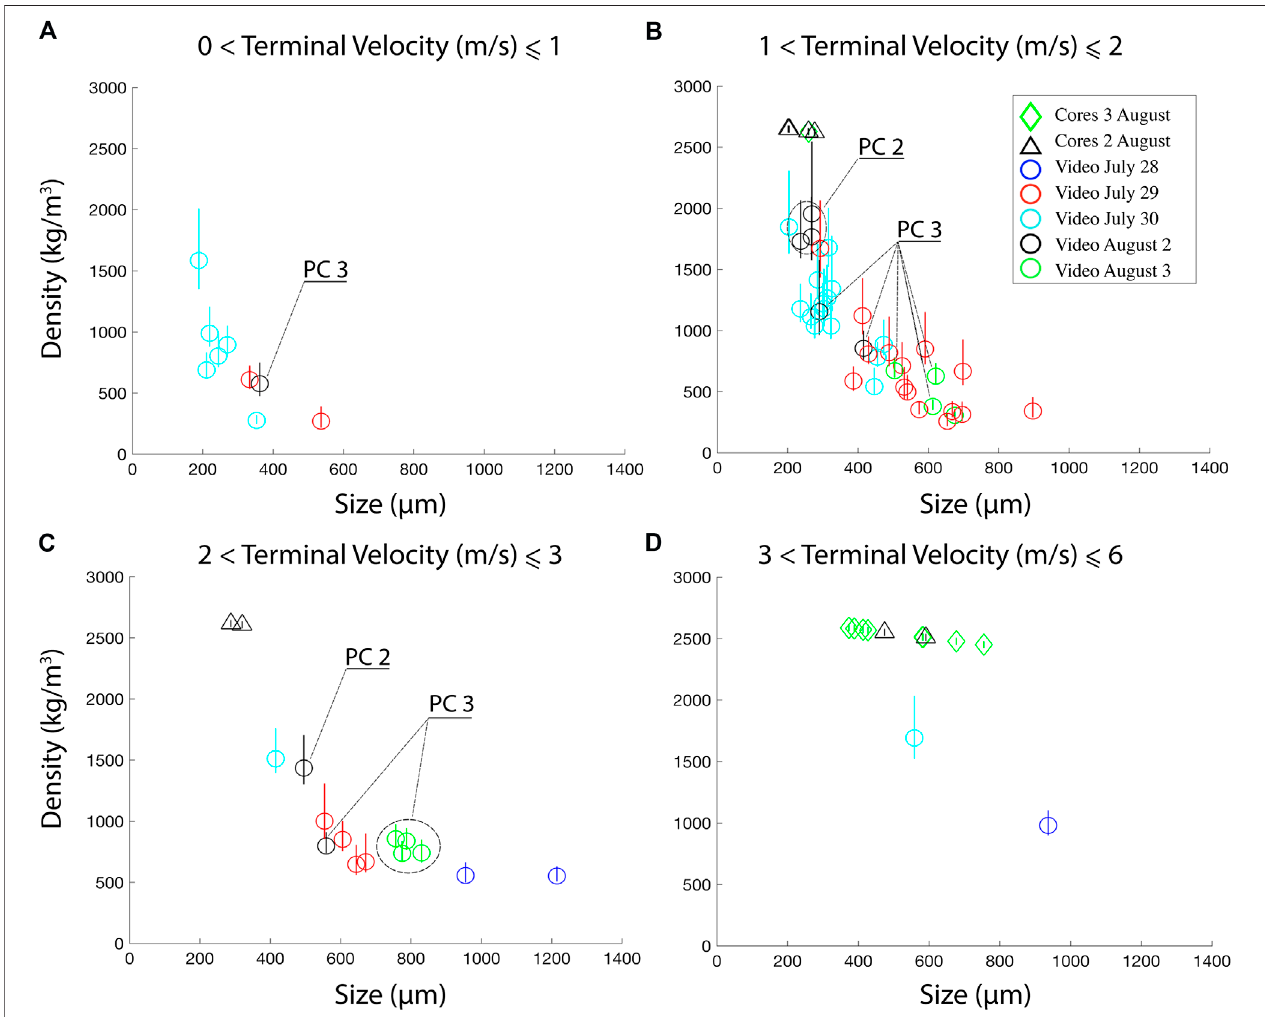
FIGURE 6 | Iso-velocity sections in the space Density – Terminal Velocity – Size for the studied aggregates. (A) Aggregates falling with velocity lower than 1 m/s, (B) between 1 and 2 m/s, (C) between 2 and 3 m/s, and (D) between 3 and 6 m/s. Types of aggregates collected on August 2 – 3 was determined based on video analysis and is speci fi ed with